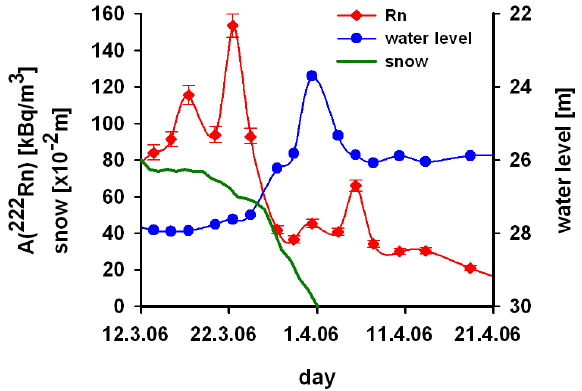
Fig. 3. Radon activity concentration decrease in V-2 borehole after the snow melting. Vertical bars represent the standard deviation of the radon activity concentration